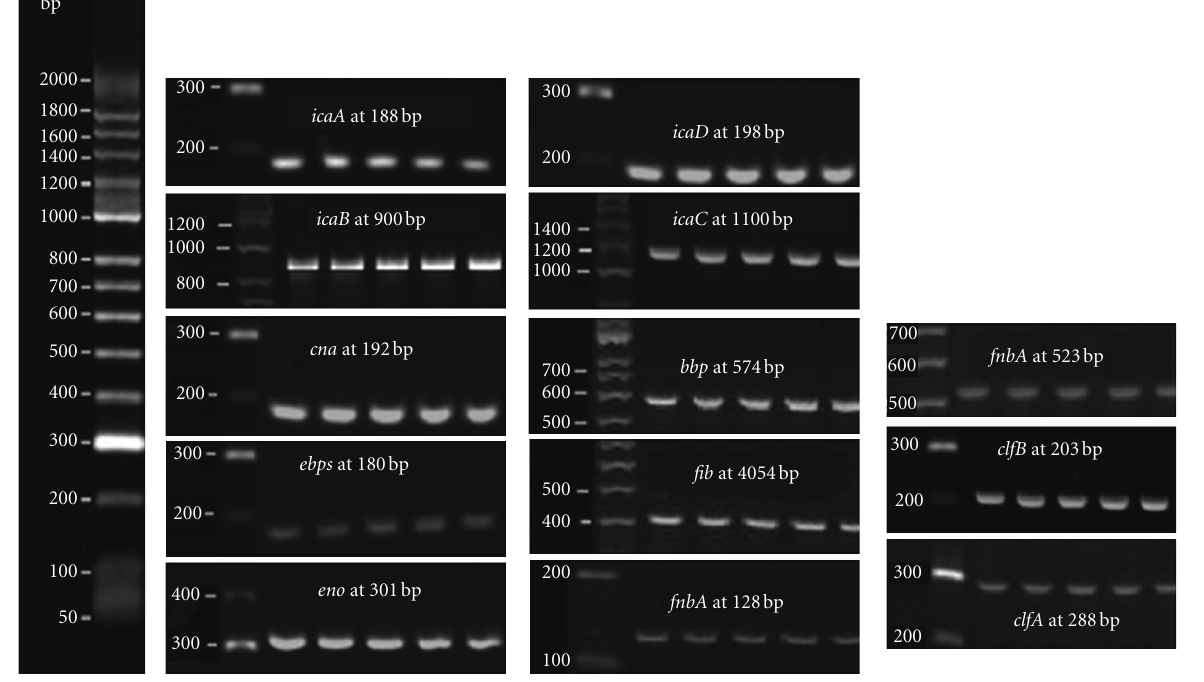
Figure 4: Products of RT-PCR performed on RNA isolated from MSSA and MRSA clones. The presence of RT-PCR products indicates expression of 13 adhesion and biofilm genes. All the genes in this figure were prepared by cutting and pasting from original amplified products in the gel for each gene determined in this study. M100 is DNA base pair size